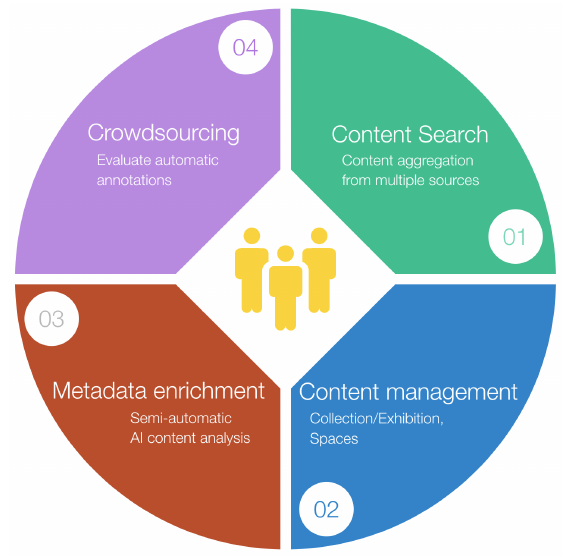
Figure 4. User involvement in the proposed